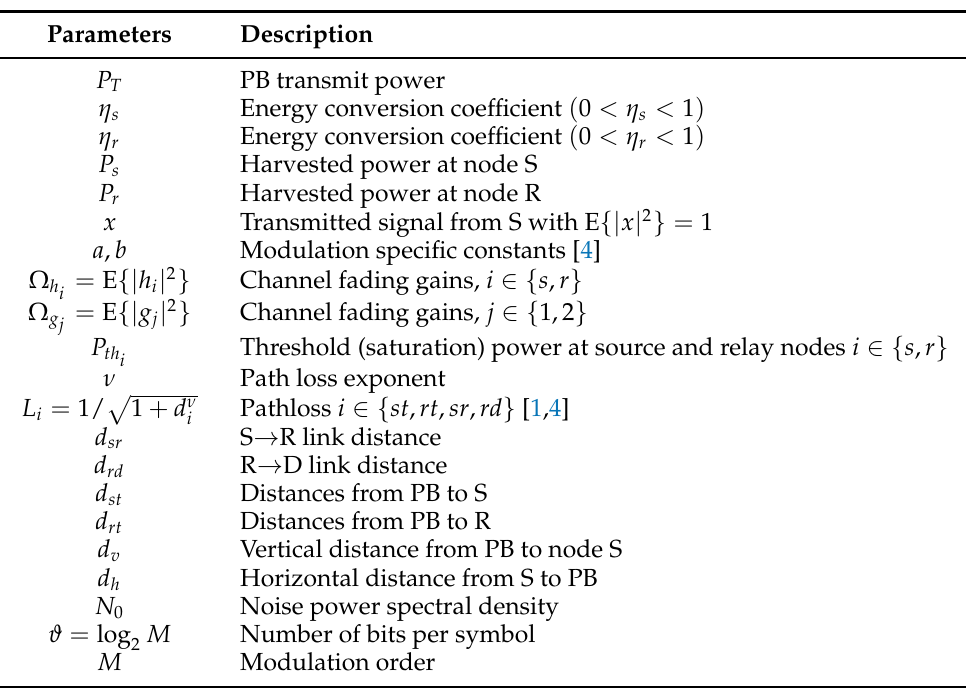
Table 2. List of